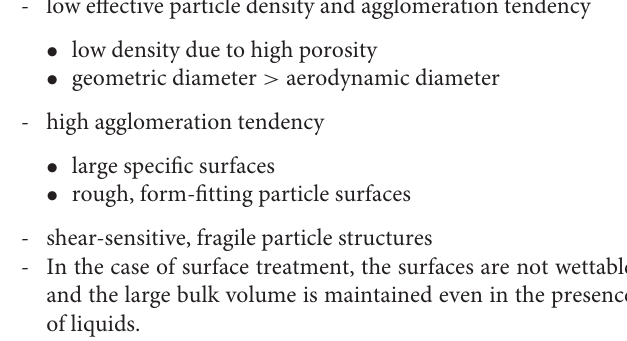
FIGURE 1 | Range of aerodynamic PSD according to OECD Guideline 436: : OECD min x ae,50 = MMAD = 1 µ m, σ g = 1.5; OECD max 4 µ m, σ g =